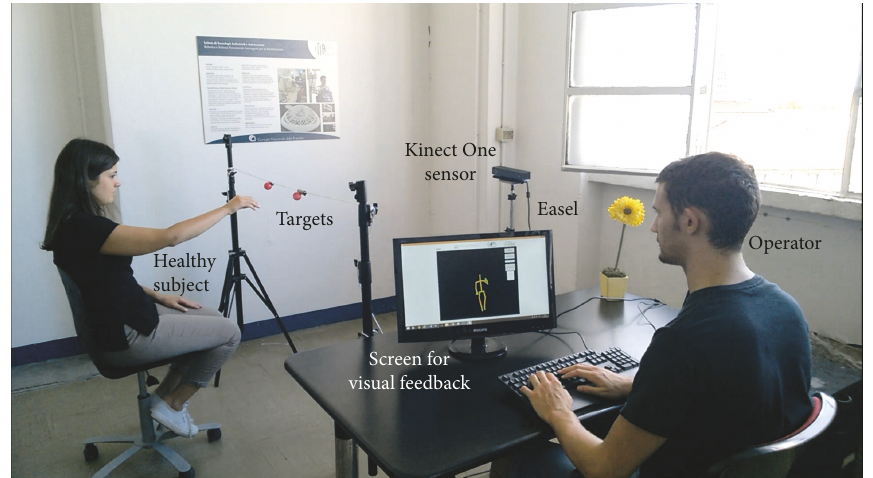
Figure 3: The experimental